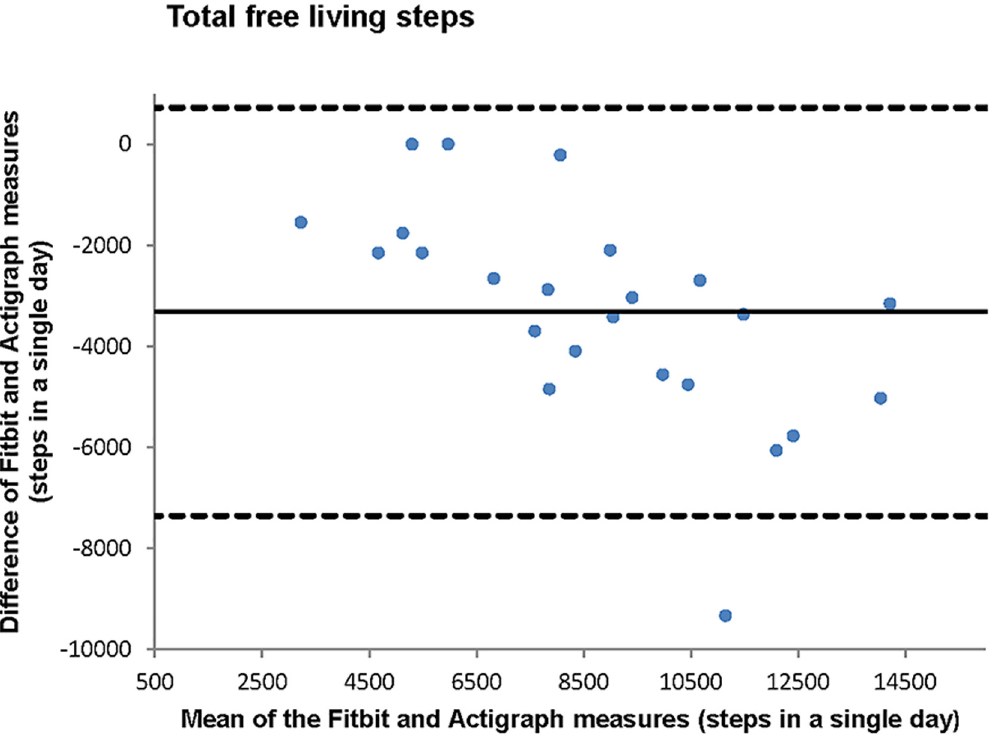
Fig 3. Bland-Altman plot of free living steps for the Fitbit compared to the Actigraph.